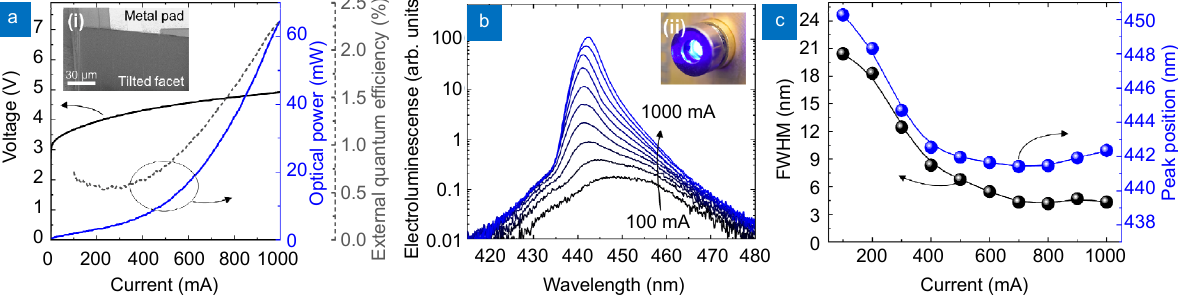
Fig. 1 | SLD device and electro-optical characteristics. ( a ) Light-output-power – current – voltage (L–I–V) and external quantum efficiency (EQE) characteristics of the SLD at CW injection current. ( i ) Scanning electron microscope image of the SLD showing the metal contact (on p-side) and the 12° tilted front facet. ( b ) Electroluminescence (EL) spectra of the SLD under various injection currents. ( ii ) SLD under operation coupled with a collimating lens. ( c ) Full-width at half maximum (FWHM) and peak position of the SLD as measured from